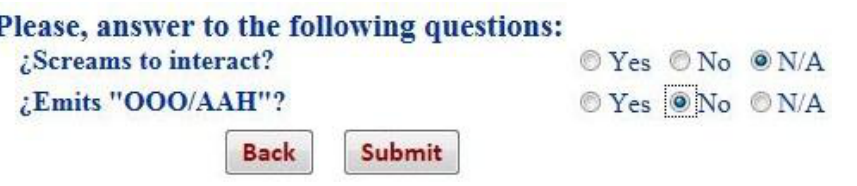
Figure 12. Process and result of language evaluation.